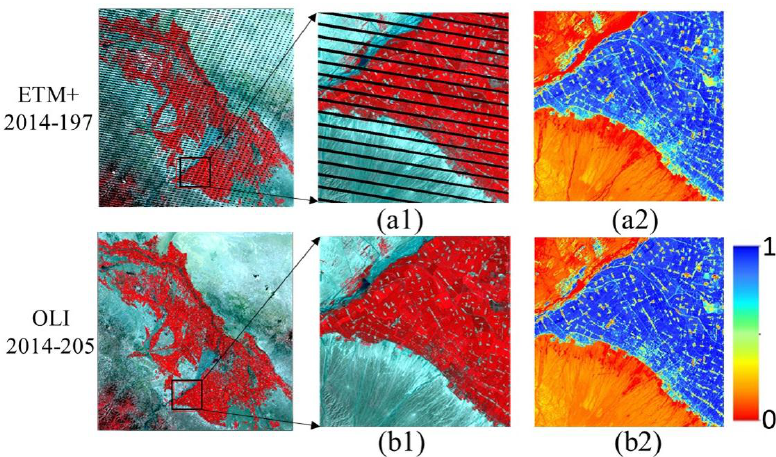
Figure 10. The FVC maps ( a2 ) and ( b2 ) derived from Landsat 7 ETM+ and Landsat 8 OLI reflectance data using the proposed algorithm. ( a1 ) and ( b1 ) The corresponding standard false color composited Landsat images with cloud and cloud shadow removed as well as gaps filled.